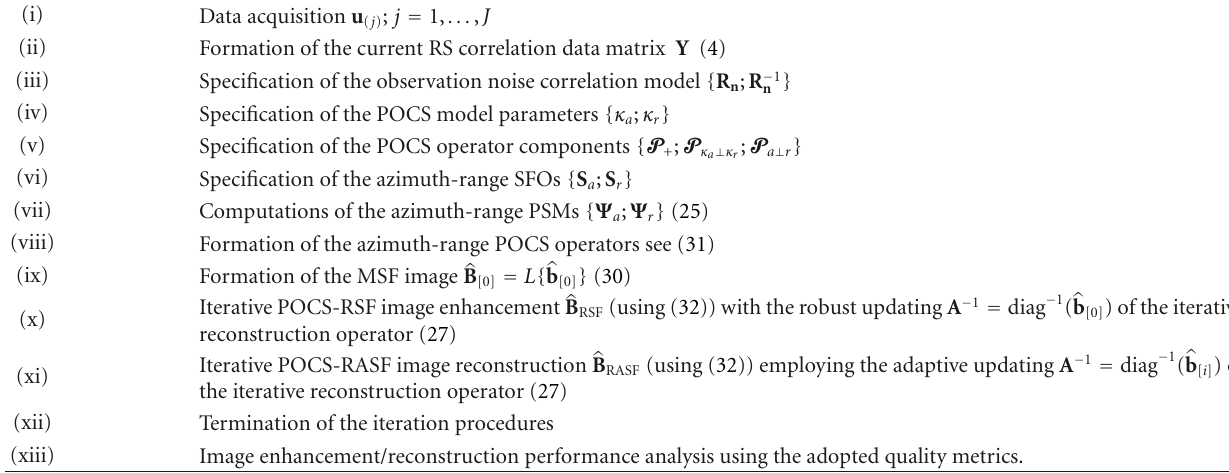
Table 1: Computational scheme for implementing the POCS-regularized RSF and RASF